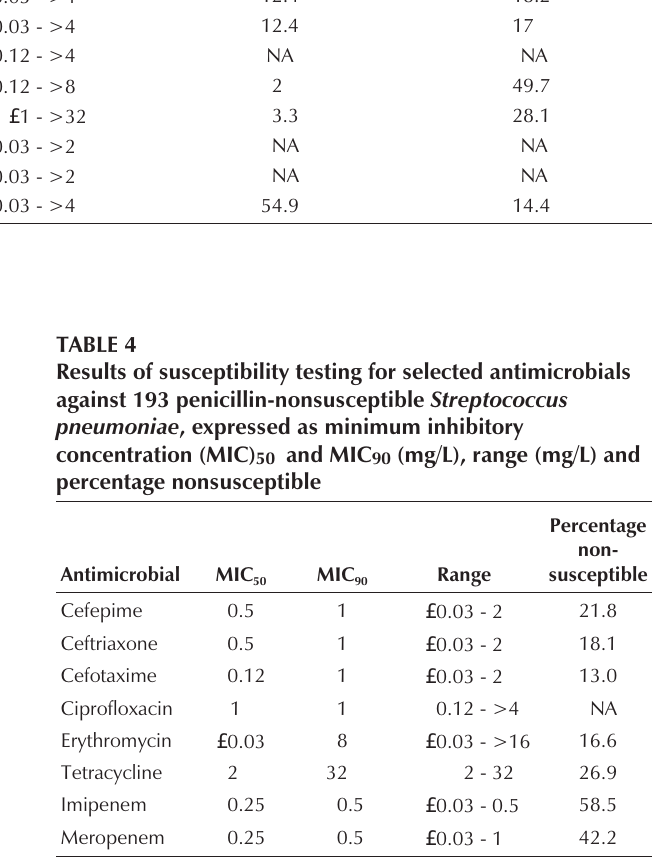
Results of susceptibility testing for selected antimicrobials against 153 viridans group streptococci expressed as minimum inhibitory concentration (MIC) 50 and MIC 90 (mg/L), range (mg/L), and percentage intermediate and resistant Antimicrobial